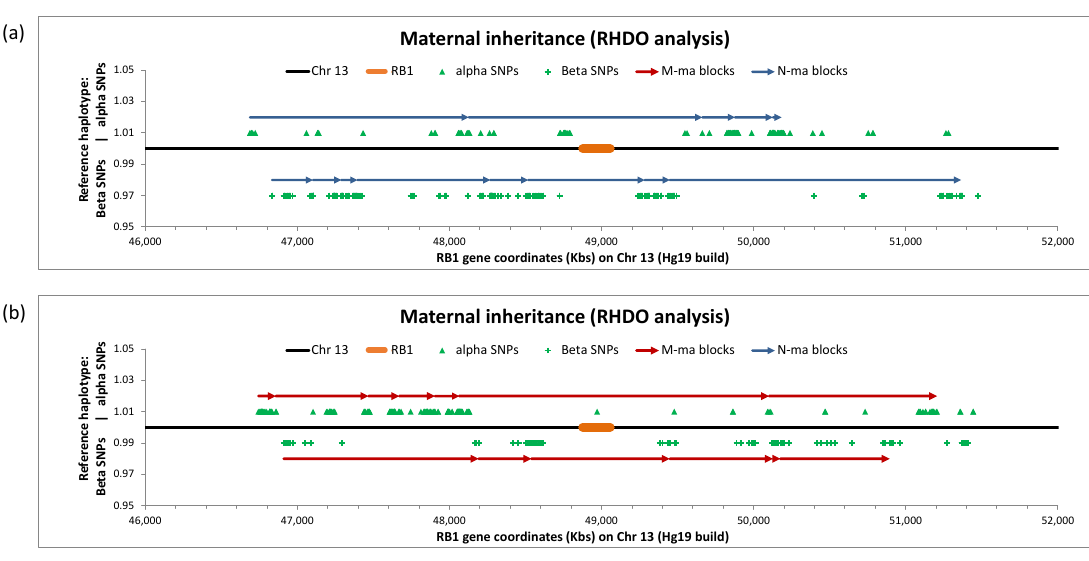
Figure 2. Graphic representation of NIPD by relative haplotype dosage analysis (RHDO) result for ( a ) Family L and ( b ) Family M at risk of maternal inheritance of retinoblastoma. Haplotype blocks are represented by contiguous arrows spanning a 5 Mb genomic region on chromosome 13 (black line) containing RB1 (orange bar). Red arrows indicate the fetus has inherited the mutated maternal (M-ma) allele. Blue arrows indicate the fetus has inherited wild-type (N-ma) alleles. The position of informative single nucleotide polymorphisms (SNPs) used to identify haplotype blocks is shown for both alpha (green triangles) and beta (green crosses)